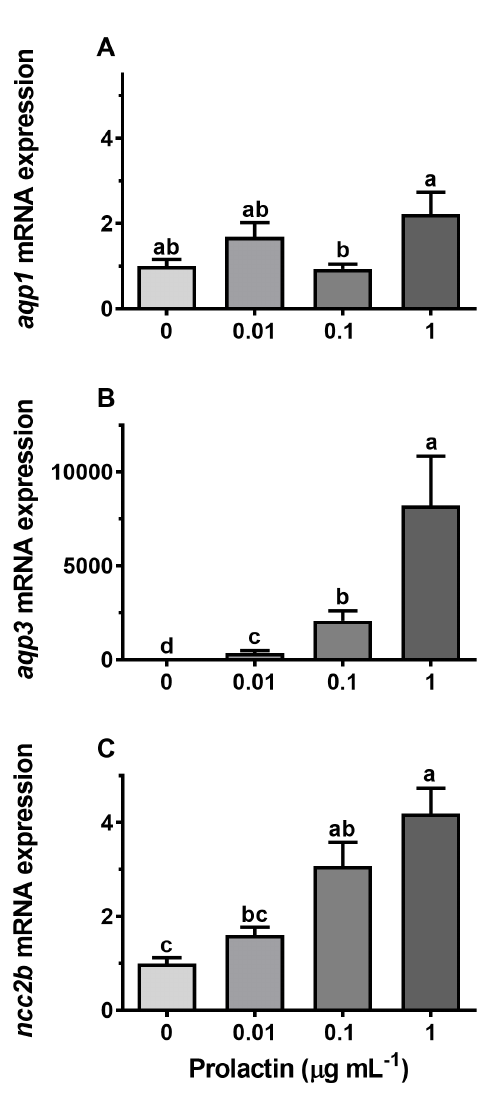
Figure 11. ( A – C ) Ex vivo dose–response of prolactin (PRL, 0.01, 0.1, and 1 µ g mL − 1 ) on AQP1 , AQP3 , and NCC2b expression in FW medaka gills. Gill explants were incubated for 18 h at room temperature. Expression of each target was normalized to the geometric mean of the three normalization genes: EF1a , bact , and RPL7 and presented relative to the control. Data are presented as mean ± standard error of the mean (n = 7–8). Bars sharing a letter are not statistically di ff erent (one-way ANOVA, P <